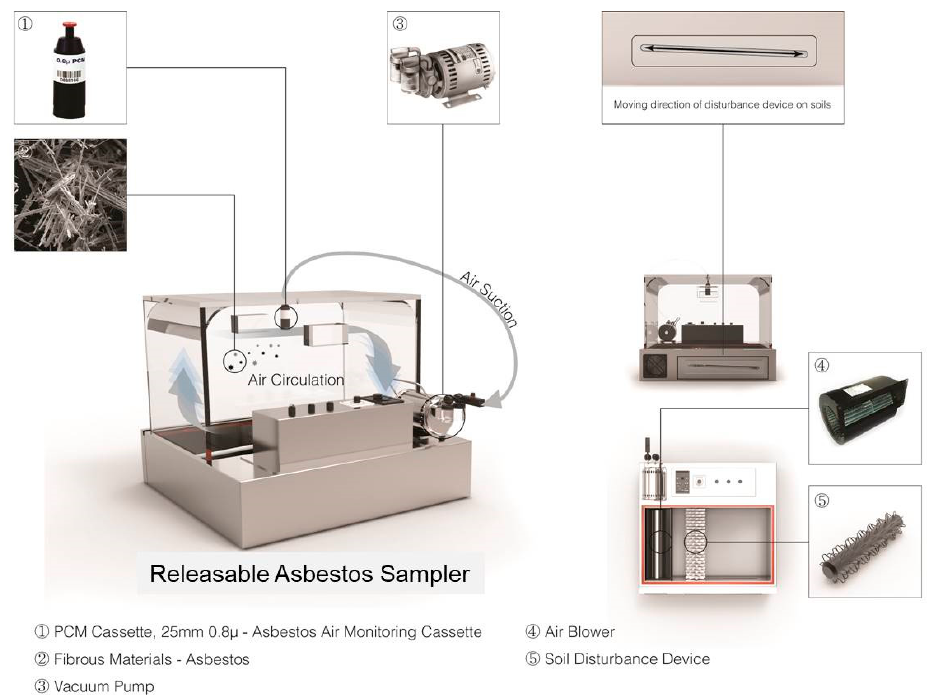
Figure 2. The modified releasable asbestos sampler (RAS) equipment adopted in this study. The sampler consists of three parts: (1) a soil disturbance device ( ⑤ ) with a horizontal-typed air